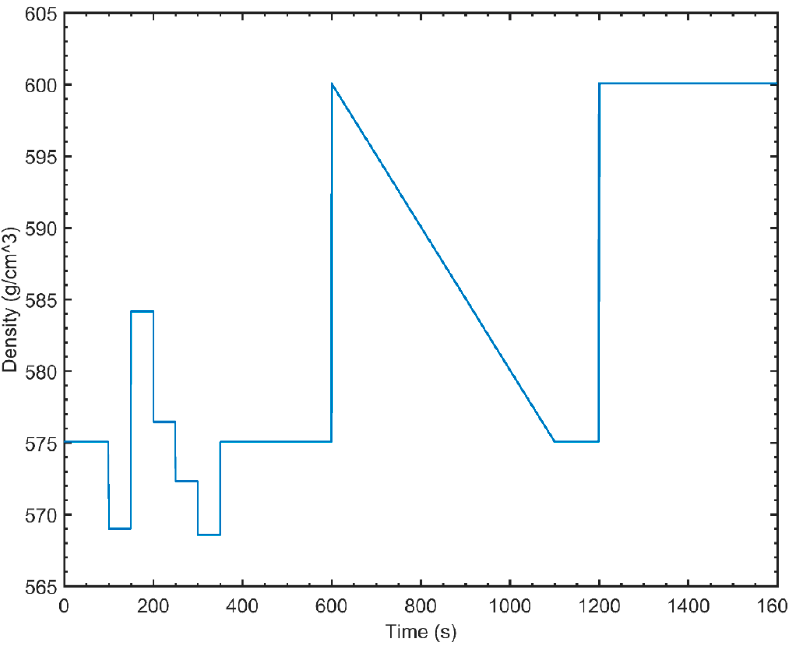
Figure 8. Density variations for disturbance rejection.